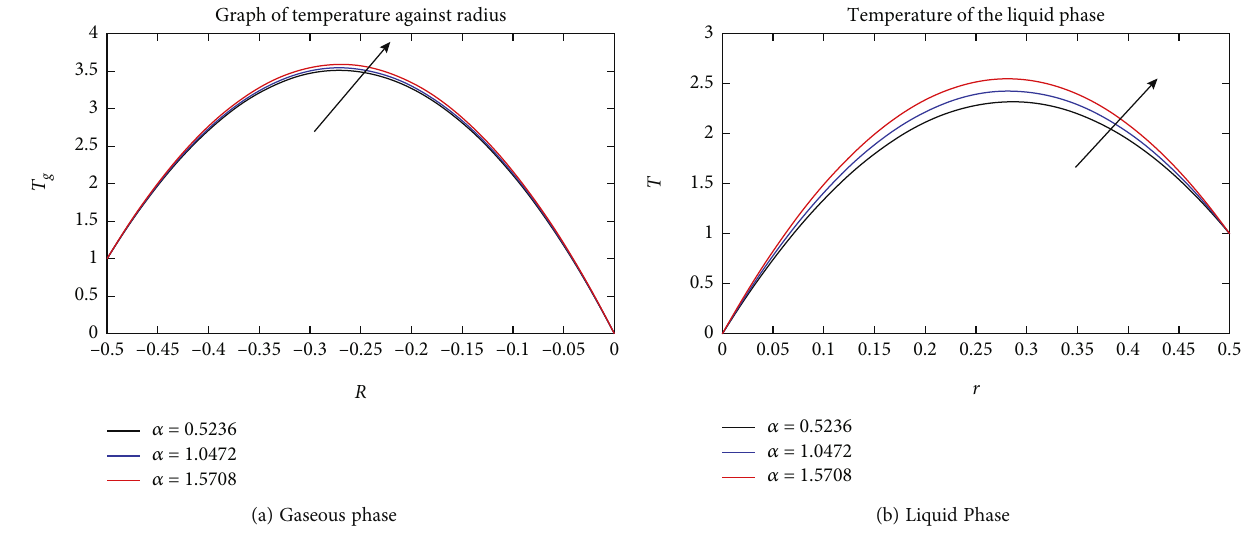
Figure 8: E ff ect of Angle of Inclination on Temperature Pro fi le.